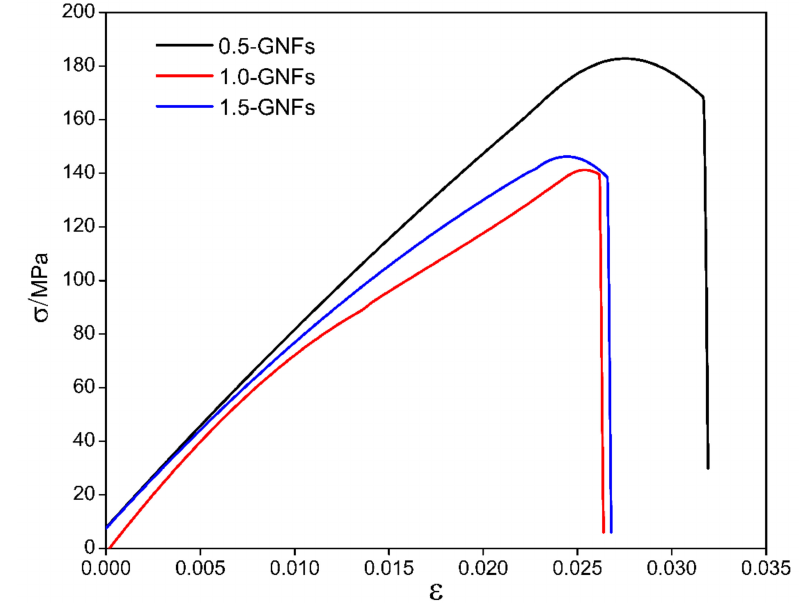
Figure 11. Compressive stress–strain curves of nanocomposites sintered at 1000 ◦ C with different contents of